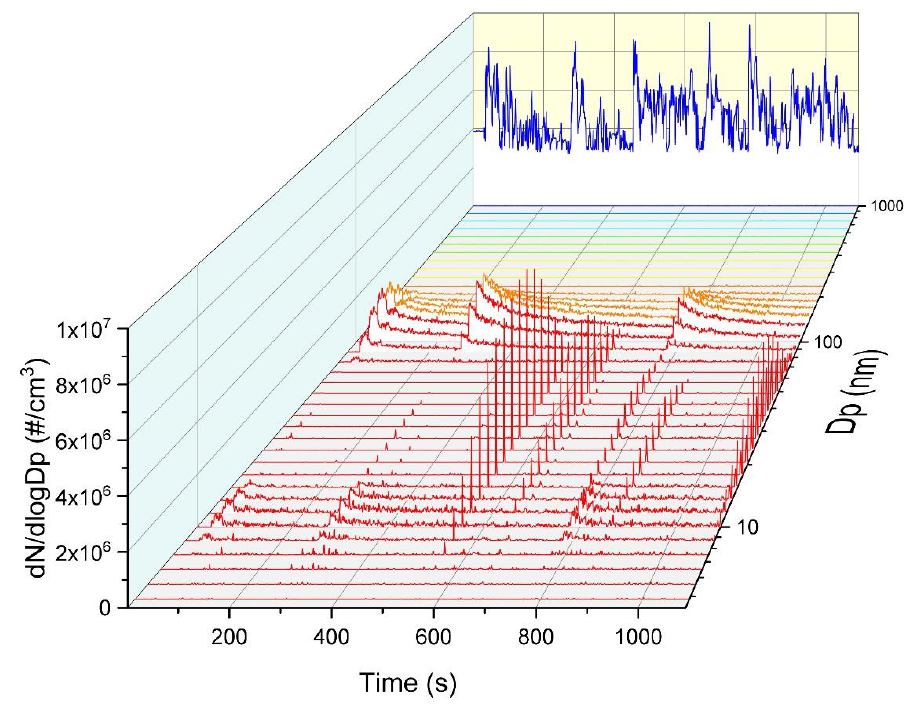
Figure 13. Example of one RDE test PNSD with time for all engine stabilised operation. Engine RPM is indicated in blue at 3 × 10 3 times scale.